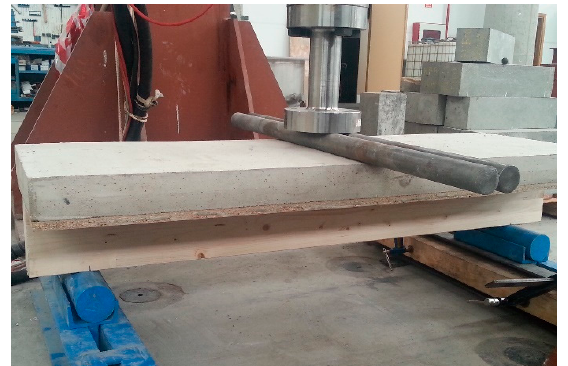
Figure 8. Diagram of the flexural failure test.